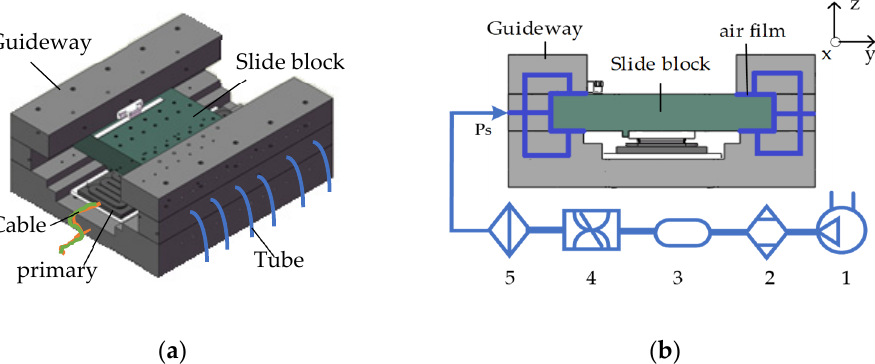
Figure 1. Structure and principle of the cableless aerostatic guideway: ( a ) overall structure of the aerostatic guideway; and ( b ) operating principle of aerostatic guideway: 1—air compressor, 2—air dryers, 3—gas tank, 4—flow control valve, and 5—filter.